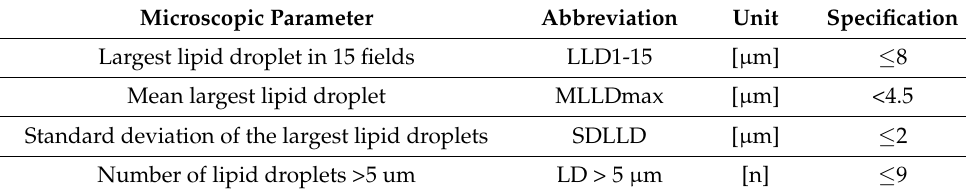
Table 2. Specifications of microscopic intravenous fat emulsion stability assessment (12). Microscopic Parameter Abbreviation Unit Specification Largest lipid droplet in 15 fields LLD1-15 [ µ m] ≤ 8 Mean largest lipid droplet MLLDmax [ µ m] <4.5 Standard deviation of the largest lipid droplets SDLLD [ µ m] ≤ 2 Number of lipid droplets >5 um LD > 5 µ m [n] ≤